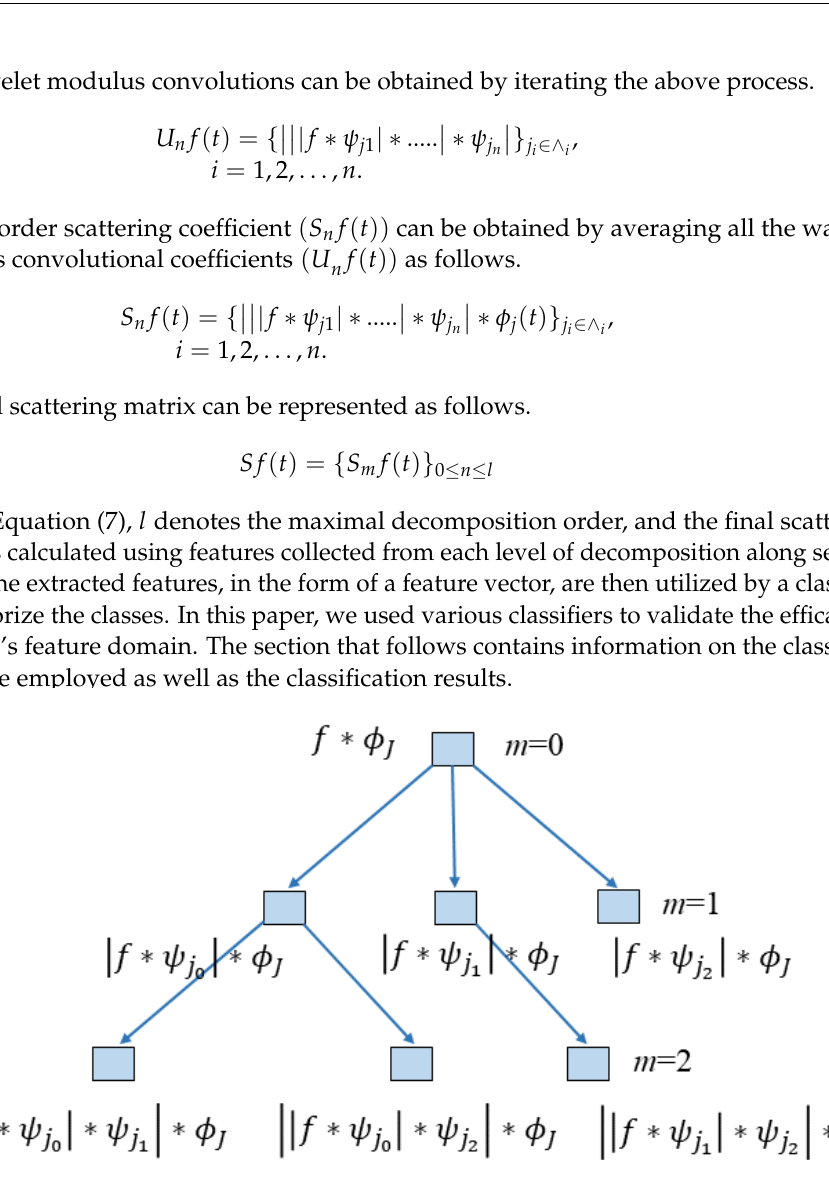
Figure 14. Wavelet scattering transform with two levels architecture for the 1D